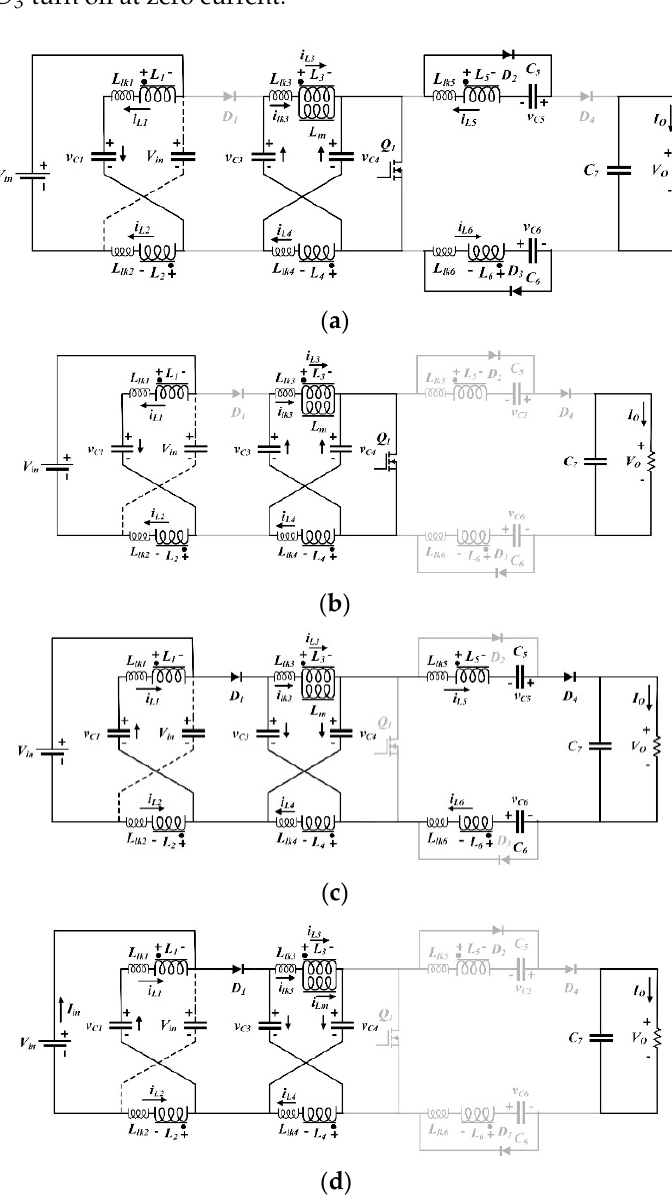
Figure 4. Equivalent circuits of the proposed converter for each operation mode. ( a ) interval 1, ( b ) interval 2, ( c ) interval 3, ( d ) interval 4.